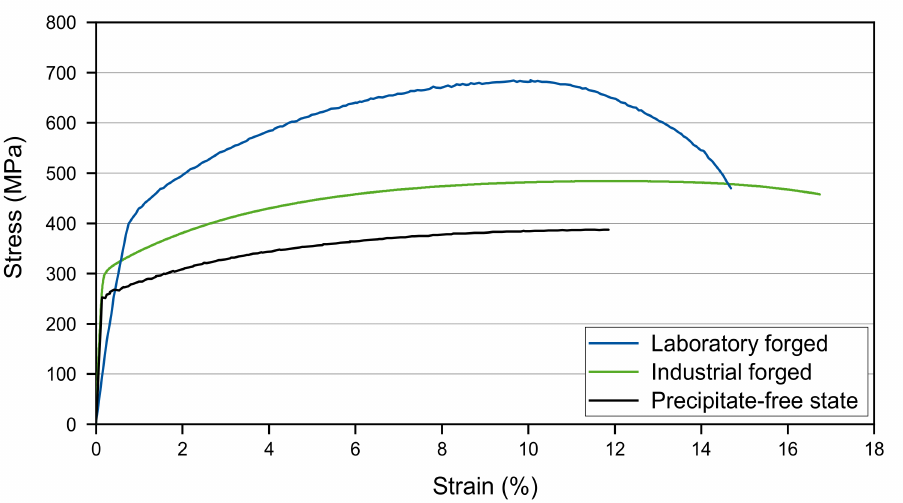
Figure 4. Tensile testing results of the Fe17Cr2.6W1Nb model alloy after the laboratory and the industrial forging experiments in comparison to the solution treated (i.e., undeformed, precipitate- free)